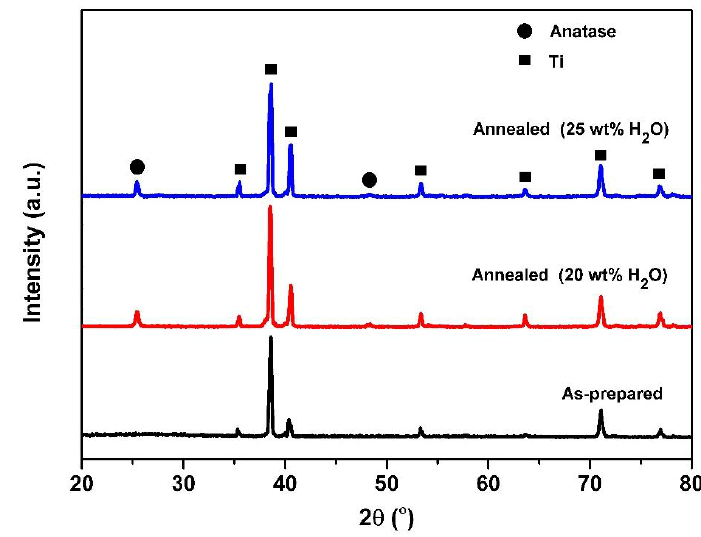
Figure 1. XRD patterns of TiO 2 nanotubes (TiO 2 NTs) obtained from anodization of Ti-6Al-4V alloy (before and after annealing treatment) at different water contents: 20 wt% and 25 wt% H 2 O. Molecules 2020 , 25 , x FOR PEER REVIEW 4 of 15